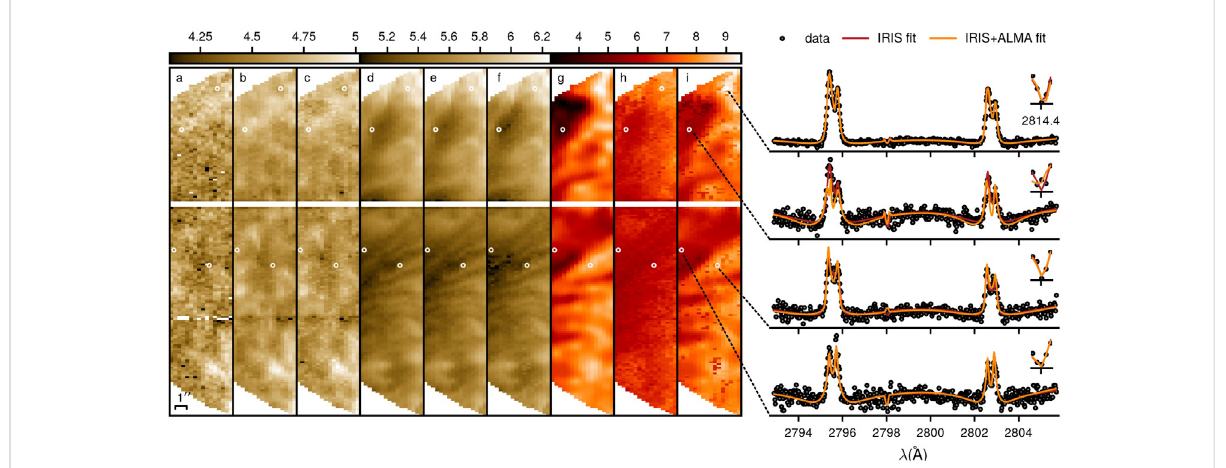
FIGURE 10 Comparisonoftheobserved (a,d,g) ,syntheticfromIRIS fi t (b,e,i) andsyntheticfromIRIS+ALMA fi t (c,f,i) temperaturemaps(kK)asafunctionof opticaldepthinaplageregion:foraveragedcontinuumat2800A (a – C) ,foraveragedkcorewavelengths (D – F) ,andforBand6 (G – I) .Thepanelson the right depict observed and synthetic IRIS spectra at selected locations. From da Silva Santos et al. (2020a). Reproduced with permission ⓒ